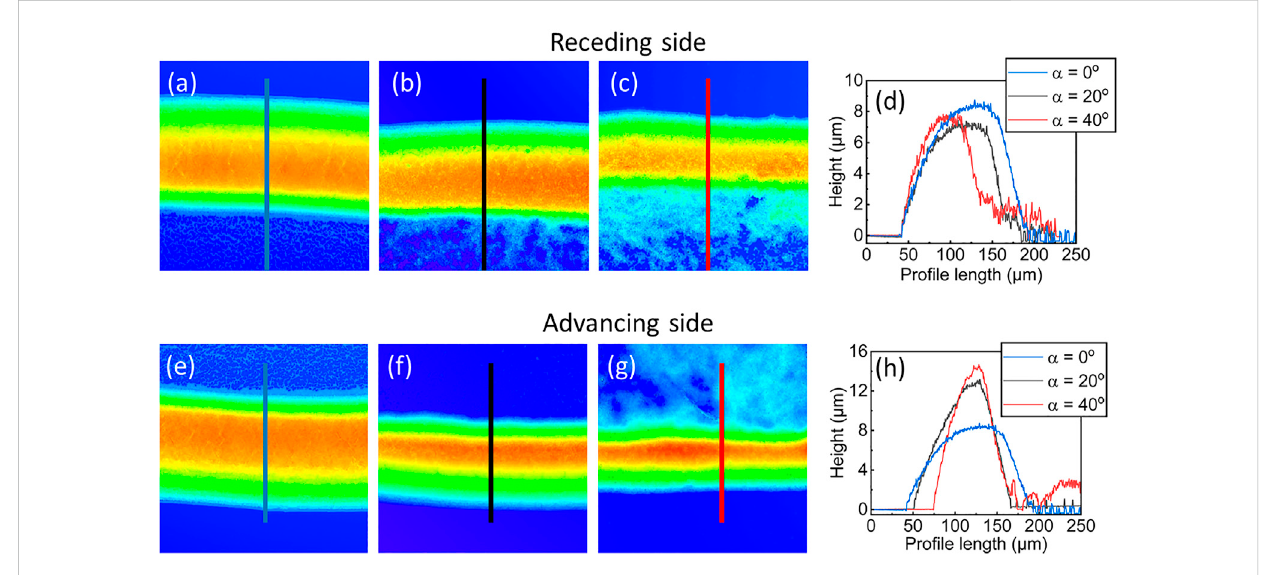
FIGURE 6 (A – C) Topography images by LSCM at the rear side with increasing inclination from left to right and (D) corresponding height pro fi les. (E – G) Topography images by LSCM at the front side with increasing inclination from left to right and (H) corresponding height pro fi les.